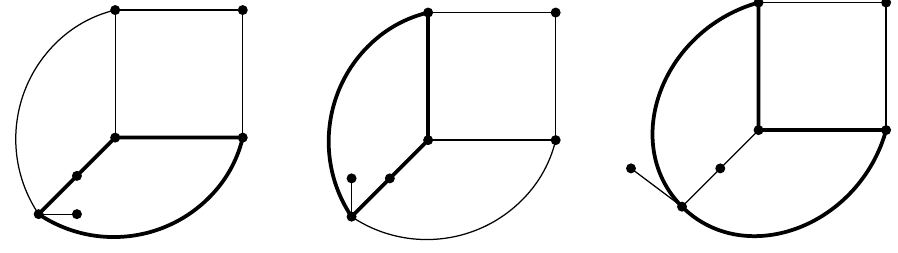
Fig. 3: We can always find such a 4 -cycle C i that x 1 and the other neighbor of x not in incident with C i are in different parts int( C i ) and ext( C i )